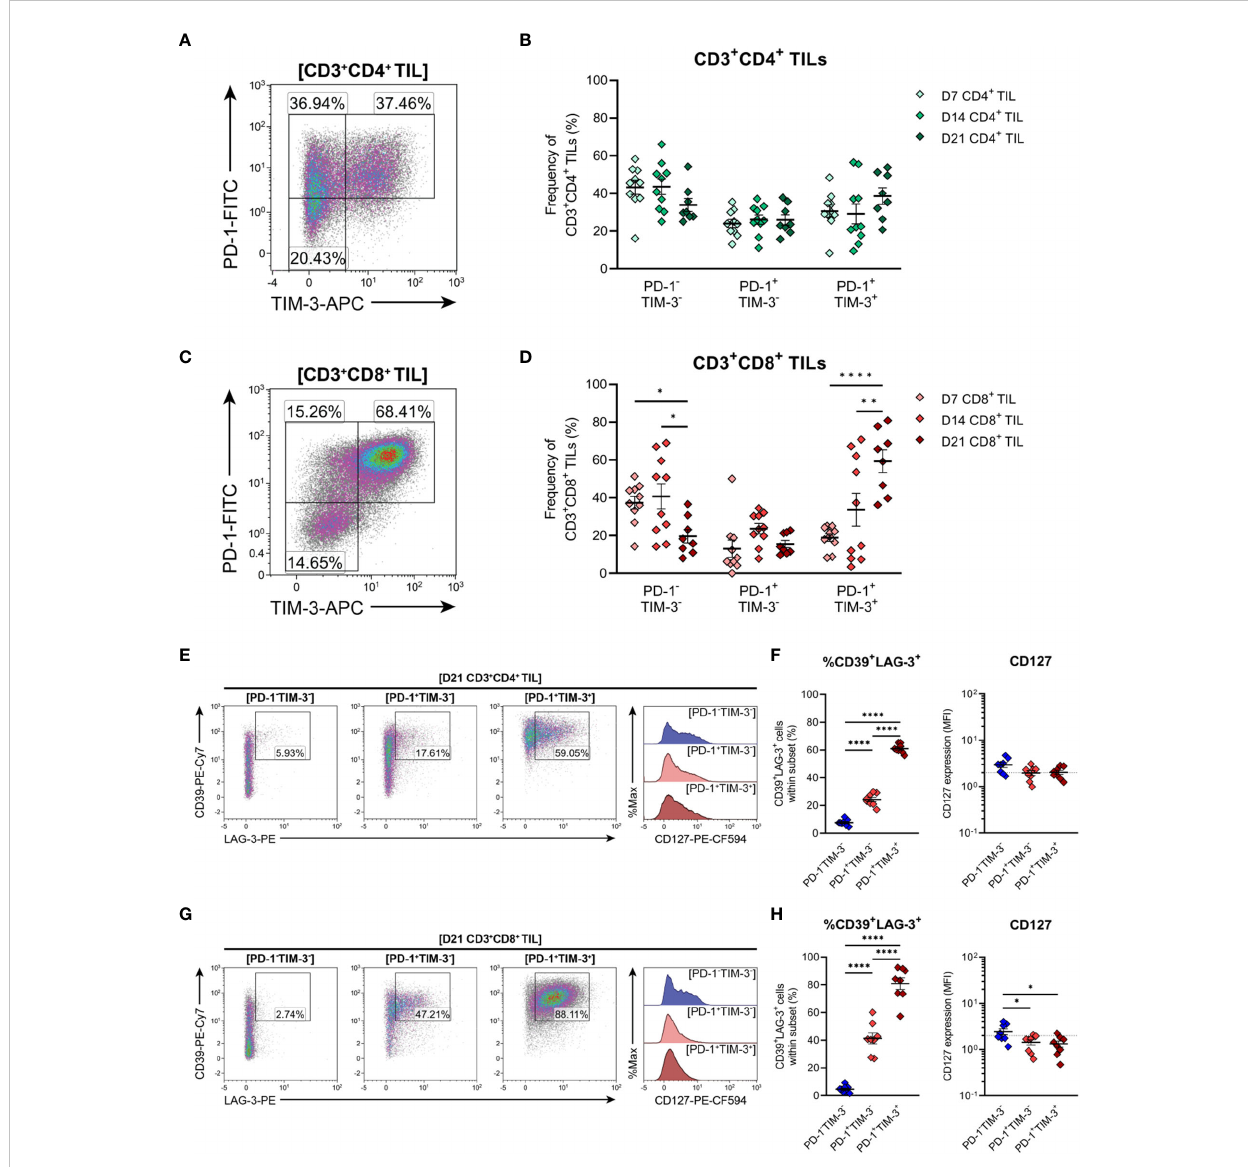
FIGURE 8 Expression of inhibitory receptors associated with exhaustion by CD4 + and CD8 + T cells in fi ltrating MC38 tumours. (A, C) Representative density plots depicting the distribution of PD-1 and TIM-3 subsets within total CD3 + CD4 + (A) and CD3 + CD8 + (C) TILs. (B, D) Frequencies of naïve-like (PD- 1 - TIM-3 - ), progenitor exhausted (PD-1 + TIM-3 - ) and terminally exhausted (PD-1 + TIM-3 + ) T cells among CD3 + CD4 + (B) and CD3 + CD8 + (D) TILs. (E, G) Representative fl ow plots depicting LAG-4, CD39 and CD127 expression in naïve-like (PD-1 - TIM-3 - ; blue), progenitor exhausted (PD-1 + TIM-3 - ; light red) and terminally exhausted (PD-1 + TIM-3 + ; dark red) T cell subsets within CD3 + CD4 + (E) and CD3 + CD8 + (G) TIL isolated from D21 MC38 tumours. (F, H) Expression of both CD39 and LAG-3 (%CD39 + LAG-3 + ) and CD127 (MFI) within PD-1 and TIM-3 subsets of CD3 + CD4 + (F) and CD3 + CD8 + (H) TIL isolated from D21 MC38 tumours. All density plot percentages indicate frequencies as the proportion of the gated population (indicated in bold titles with square brackets). All data are representative of 8-10 biological replicates per timepoint. Graphs represent the mean and standard error of the mean (SEM, error bars). Statistical analyses were performed using two-way (B, D) or one-way (F, H) ANOVA with post-hoc Tukey test to correct for multiple comparisons. *p ≤ 0.05; **p ≤ 0.01; ****p ≤